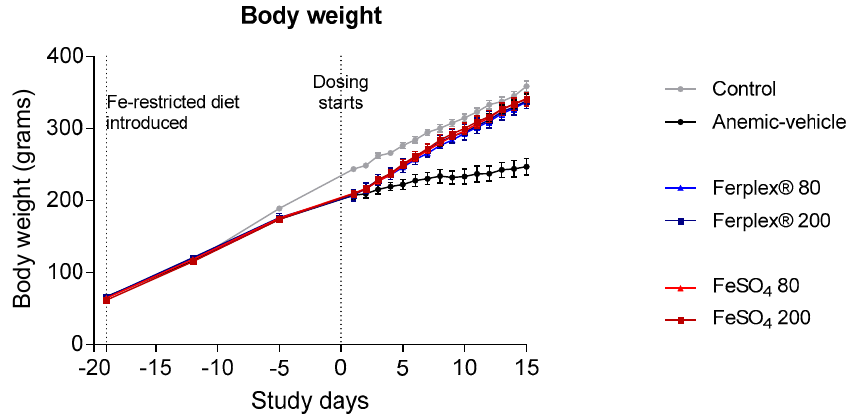
Figure 2. Body weight monitoring during anemia induction and treatment period. Weights were monitored daily from day 0 to day 14, when the study was terminated. Data are presented as mean ± SEM. No significant difference was found between treatment groups (Ferplex ® versus FeSO 4 ) or between the 80 vs. 200 mg doses. No statistical difference was found between treatment groups and control at study termination. Data were analyzed by means of a Kruskal-Wallis test and with Dunnett’s multiple comparison test. N = 6 (anemic-vehicle and Ferplex 200 at day 15), 7 (FeSO 4 80 and 200), 8 (control and Ferplex ® 80).